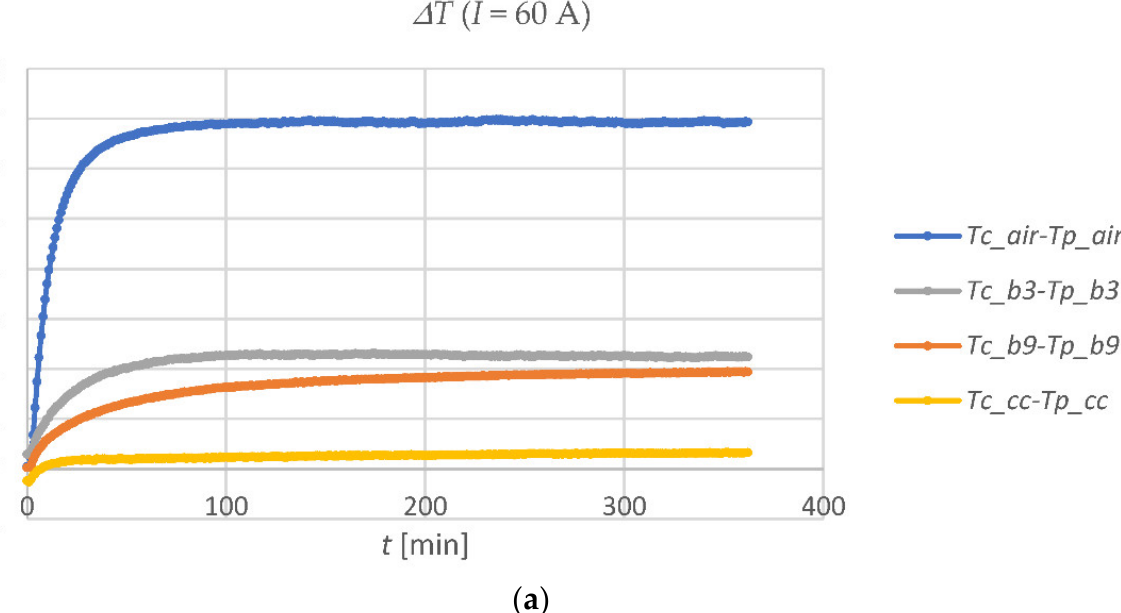
Figure 6. Temperature charts on the test stand after switching off the 120 A current. The thermal time constants of the individual media in the casing pipes strongly depend on the value of their thermal conductivity. A greater time constant means the possibility of increasing the instantaneous permissible current carrying capacity of the cable line. This is due to the lower temperature variation of the cable, caused by the change in the current in the cable, than the temperature variation that would occur in the overhead line. The time changes of the differences ∆ T between the temperatures indicated by the sensors placed in positions 1 (cid:13) and 2 (cid:13) (Figure 3) in each of the four casing pipes, after switching on the current in the cable, are shown in Figure 7. Figure 7a relates to 60 A, and Figure 7b to 120 A.